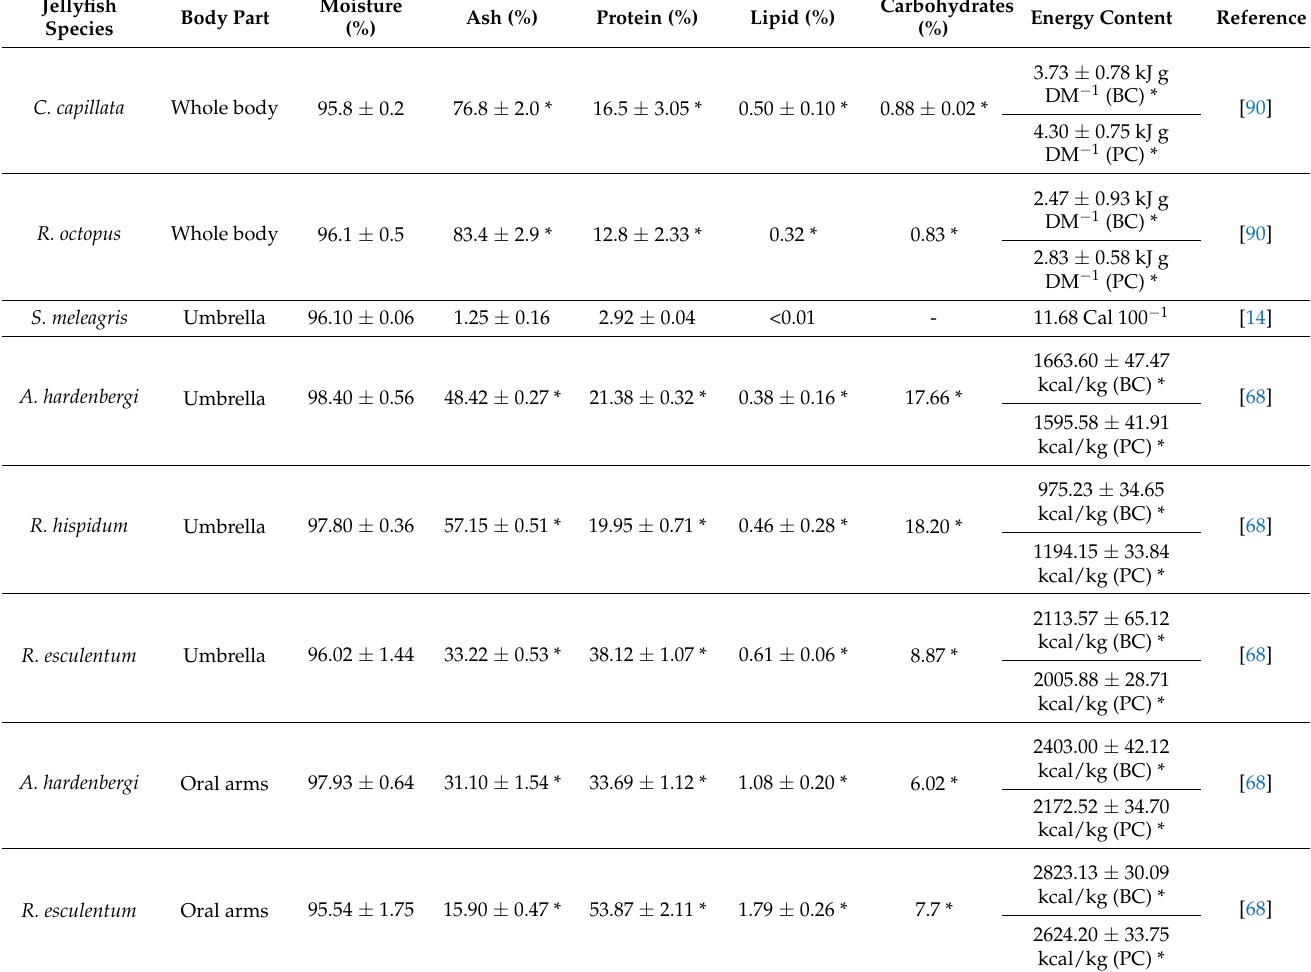
Table 2. Proximate jellyfish compositions. Adapted from ref.